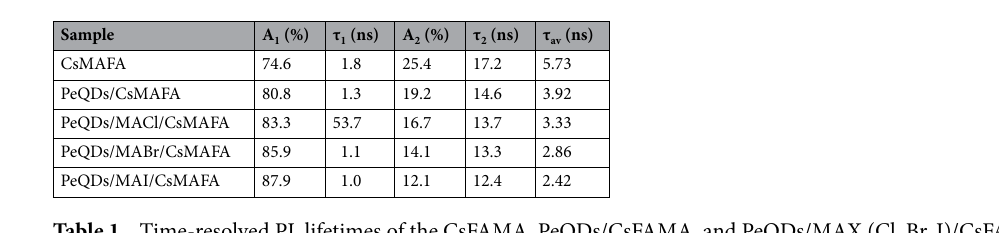
Table 1. Time-resolved PL lifetimes of the CsFAMA, PeQDs/CsFAMA, and PeQDs/MAX (Cl, Br, I)/CsFAMA perovskite films.